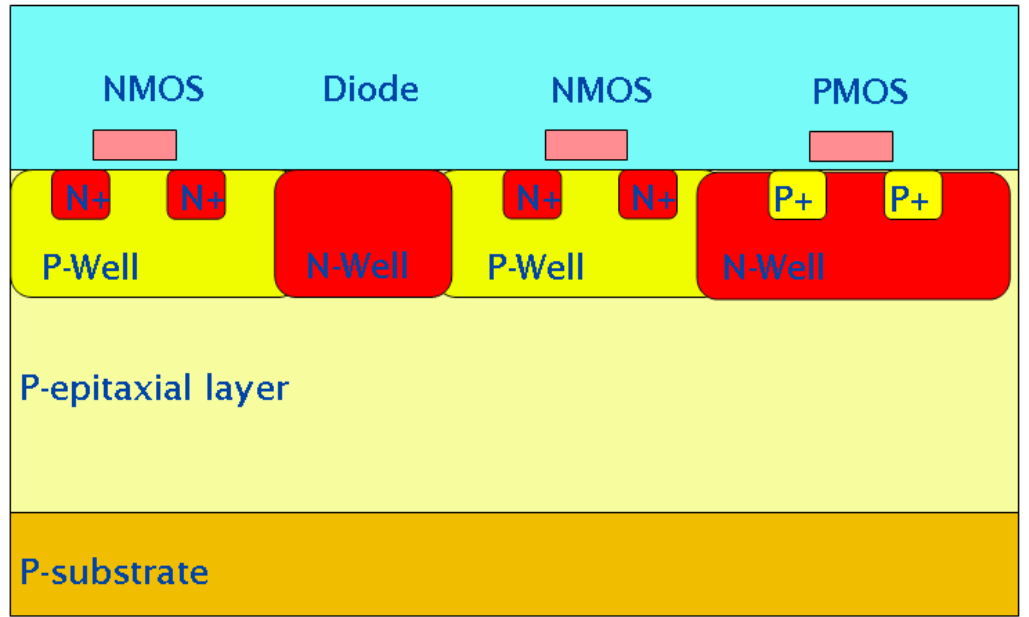
Figure 1. Schematic cross-section of a typical CMOS wafer. Not drawn to